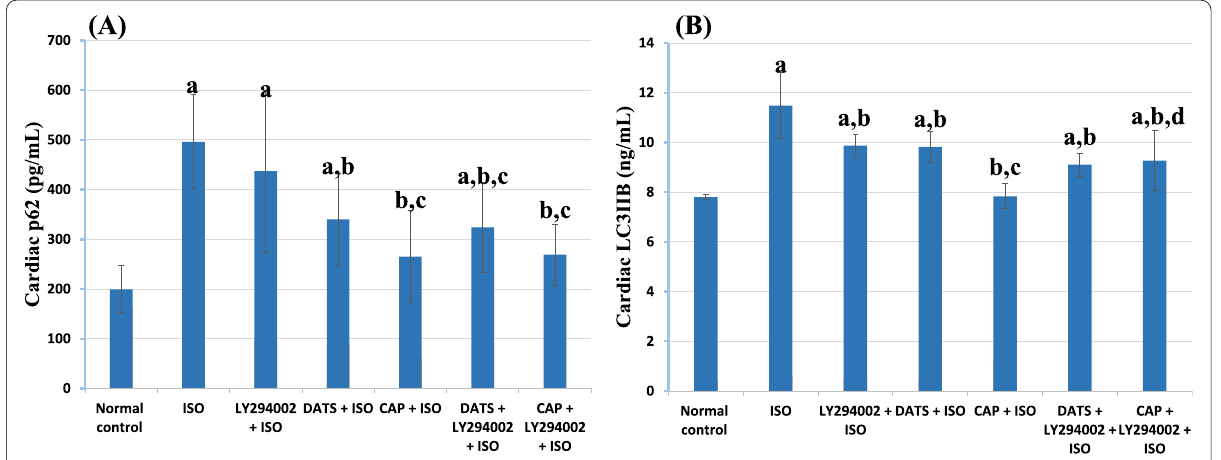
Fig. 1 Effect of treatment on cardiac autophagy biomarkers in studied groups. A Cardiac P62 concentration (pg/mL). B Cardiac LC3IIB concentration (ng/mL). Data are presented as mean Significant versus ISO group. c: Significant versus LY294002 (85 mg/kg isoproterenol), LY294002 Captopril pretreated group (50 mg/kg), DATS and PI3K inhibitor pretreated